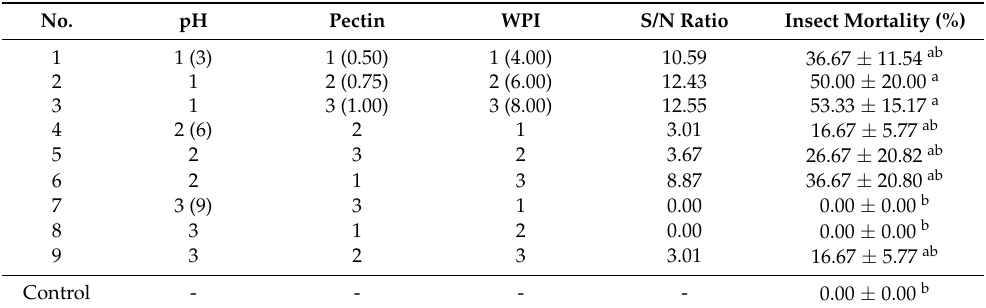
Table 1. Experimental matrix for the Taguchi orthogonal array L9 (3 3 ) and experimental results of S/N ratio and mortality of T. molitor .